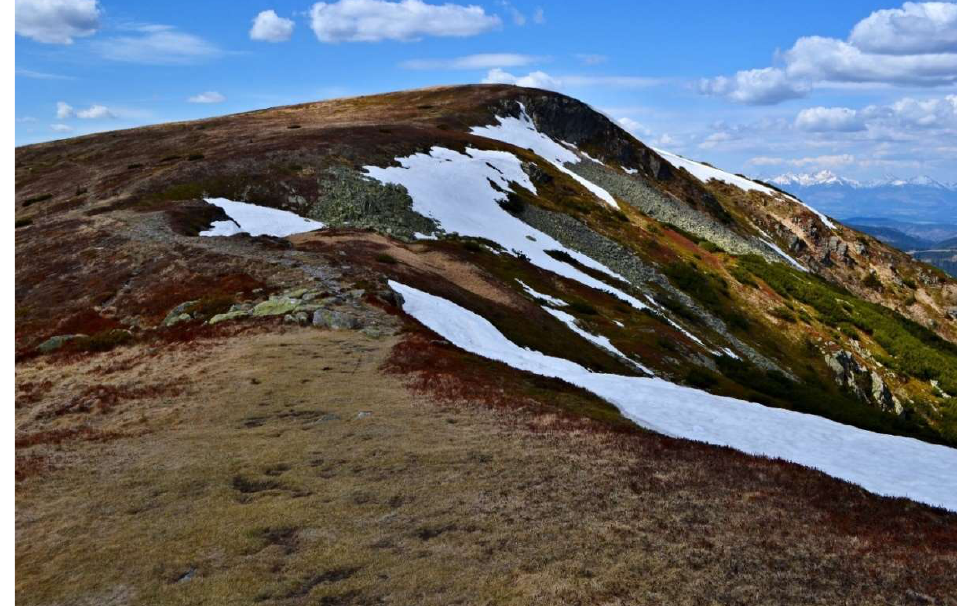
Figure 12. Identification of a trigger zone located along the edge of the glacial cirque Veľký Brunov.